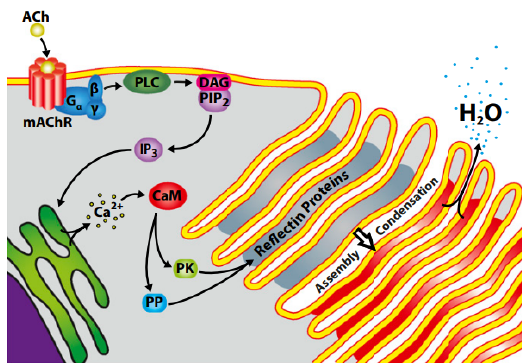
Figure 3. Proposed ACh-activated reflectin platelet condensation and iridescence tuning [32]. Cop- yright 2013, National Academy of Sciences of the United States of America.